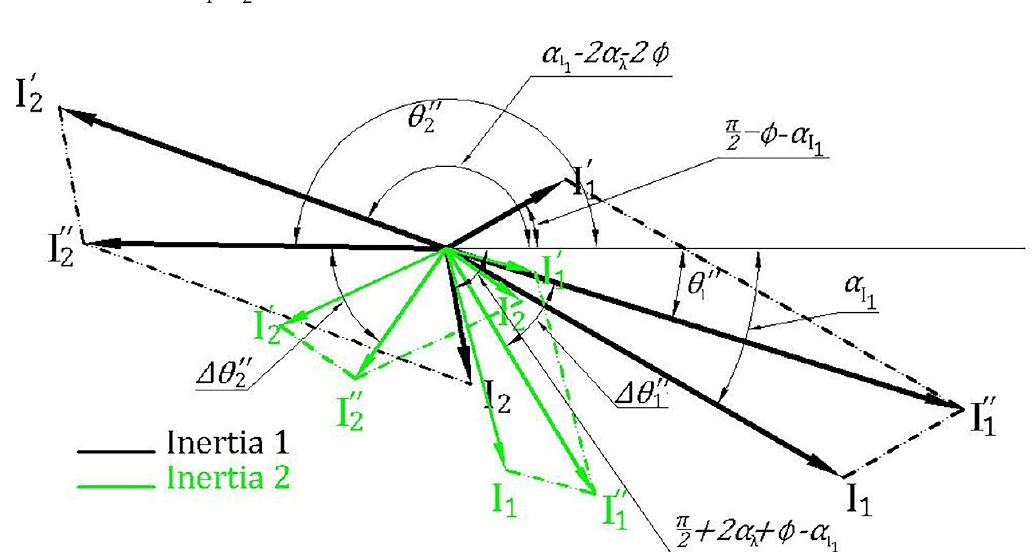
and i 2 current compo- 2 1